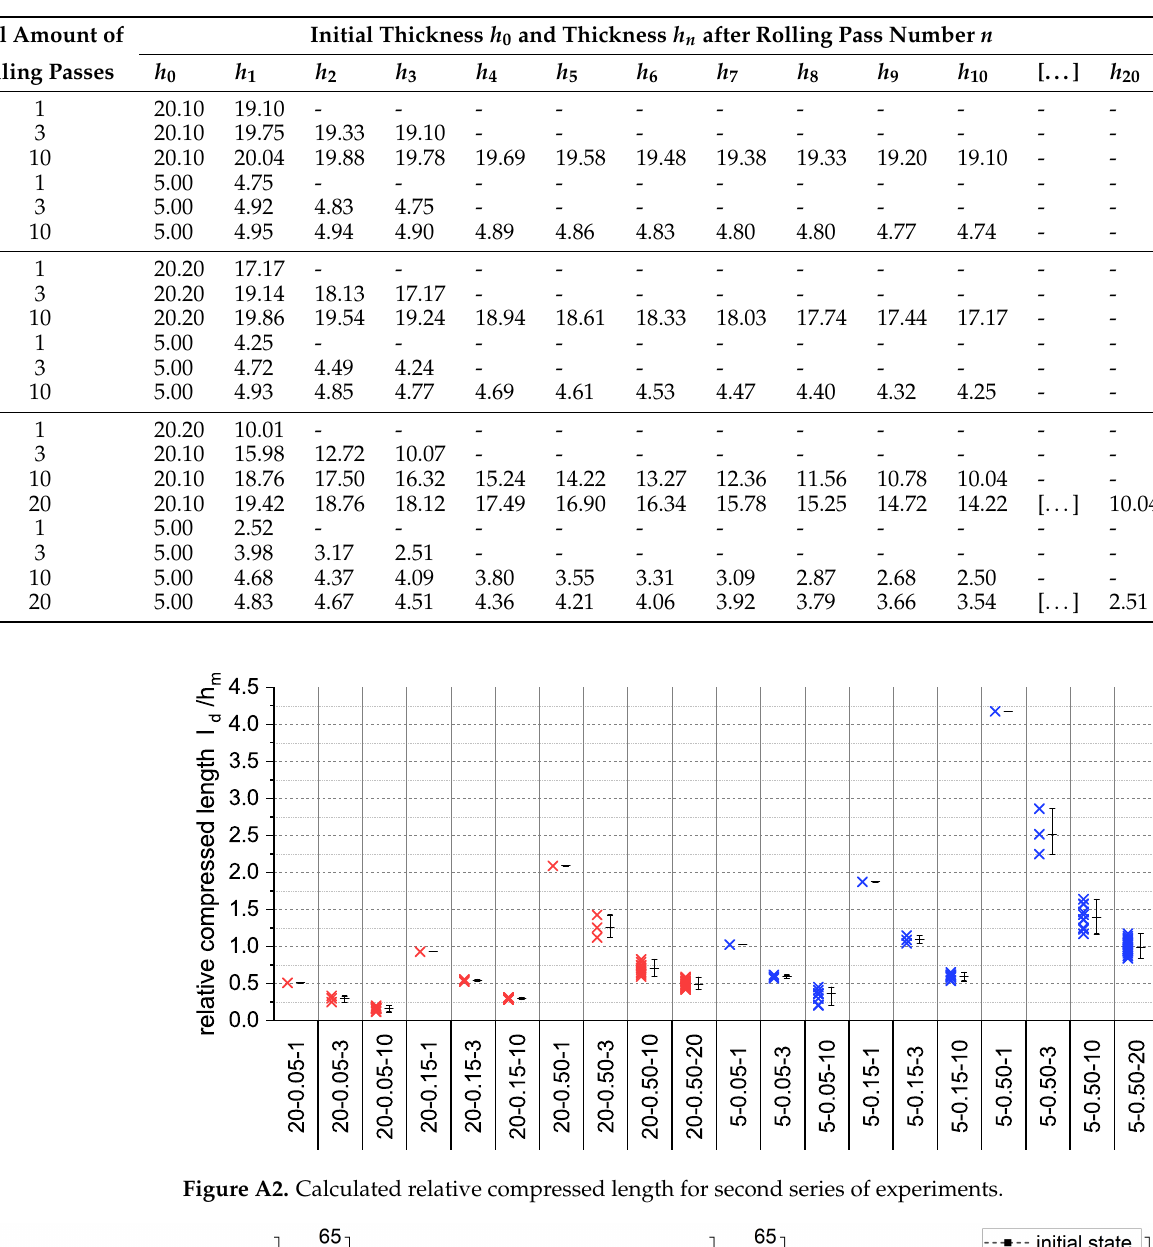
Table A2. Sample thicknesses before and after rolling for the second series of samples.